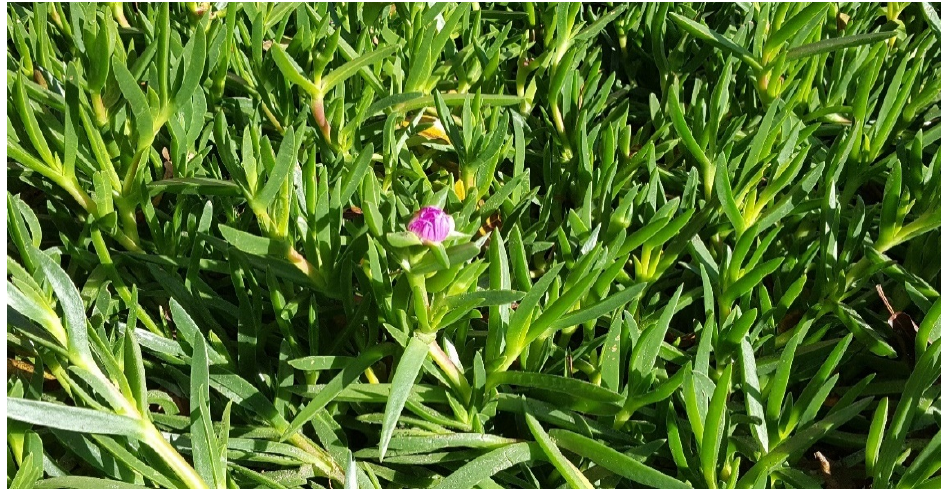
Figure 1. The flowering carpobrotus edulis plant and its taxonomy [2].